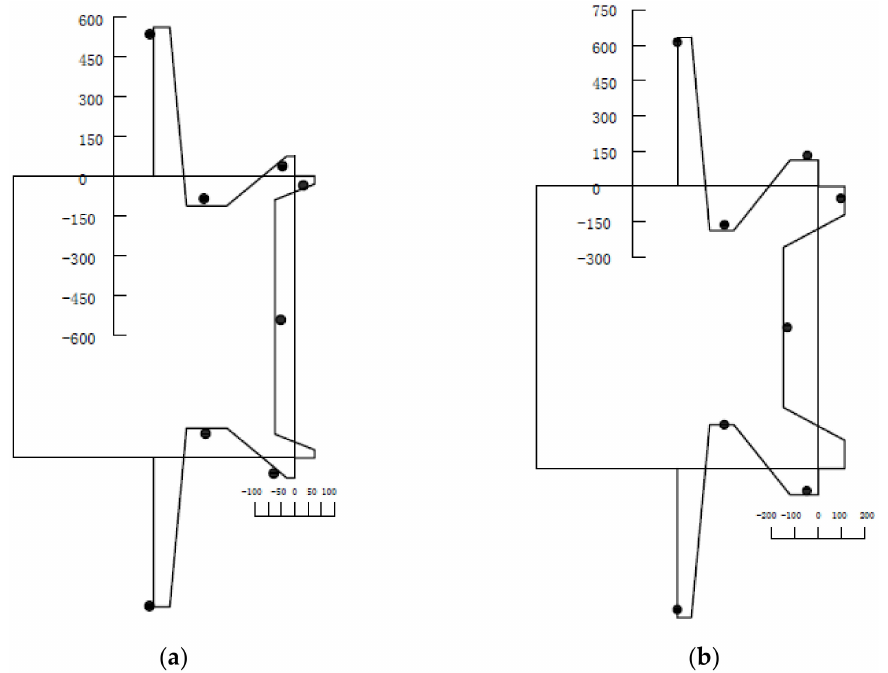
Figure 10. Residual stress model and measured data (Unit: MPa): ( a ) RS1, ( b )